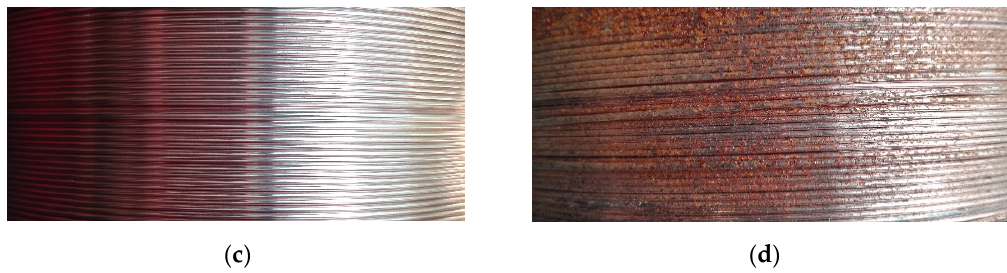
Figure 4. The surface layer of wire after storage: ( a ) A wire stored in Gdańsk welding site (GWS); ( b ) A wire stored in Mońki agricultural building (MAB); ( c ) B wire stored in Gdańsk welding site (GWS); ( d ) B wire stored in Mońki agricultural building (MAB).